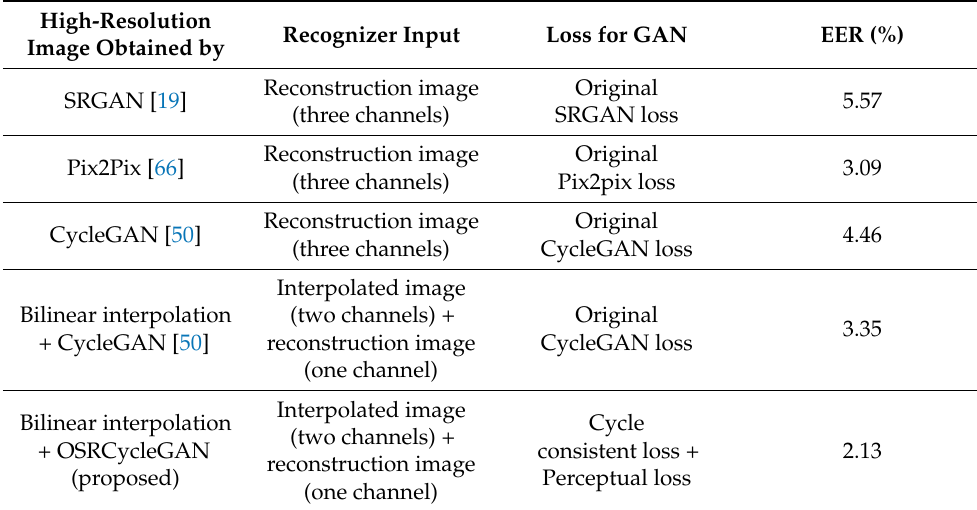
Table 10. Comparisons with state-of-the-art methods with the IIT Delhi iris database (using bilinear interpolation + Gaussian blurring when generating a low-resolution image). For the training of recognizer, train from scratch was